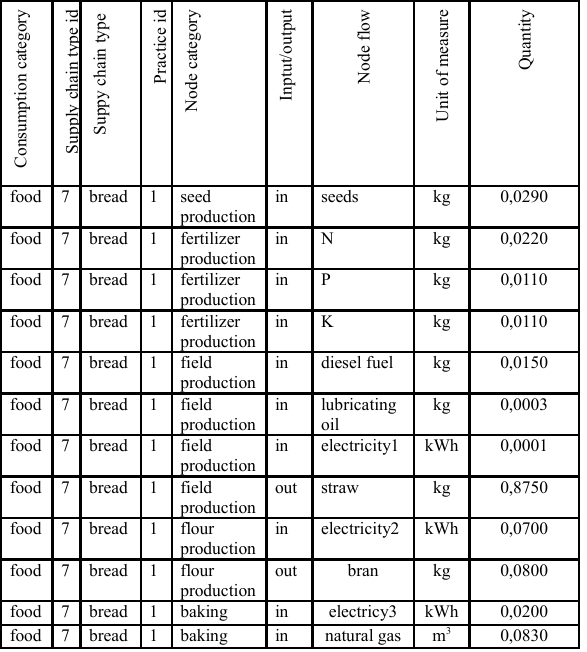
Table 1. Some of the data associated with the IG nodes of a bread supply chain, average italian practice (data refer to 1kg of bread)